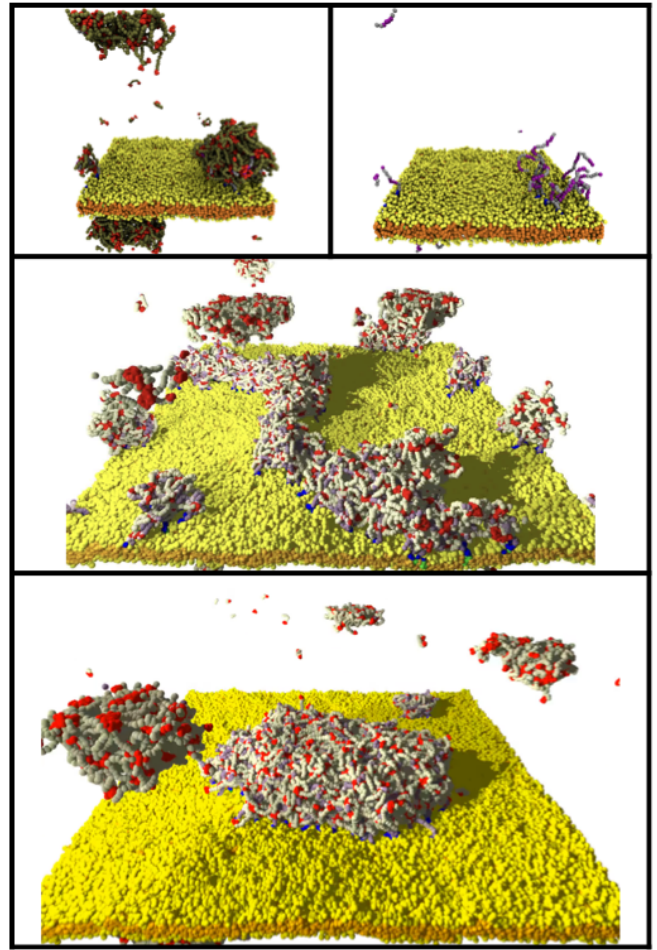
Figure 11. (Top) Clustering of linker–lipids driven by the phase separation of 395 IDPs (green with red endcaps) in the smaller system with OSPREY-DPD. (Middle, Bottom) Intermediate and final states of 1260 IDPs (white with red endcaps) in the larger system simulated by POETS-DPD.